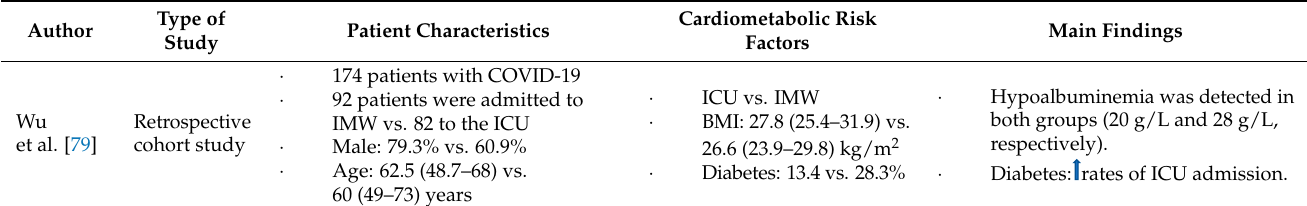
Table 2. Hypoalbuminemia in COVID-19 and Cardiometabolic Risk